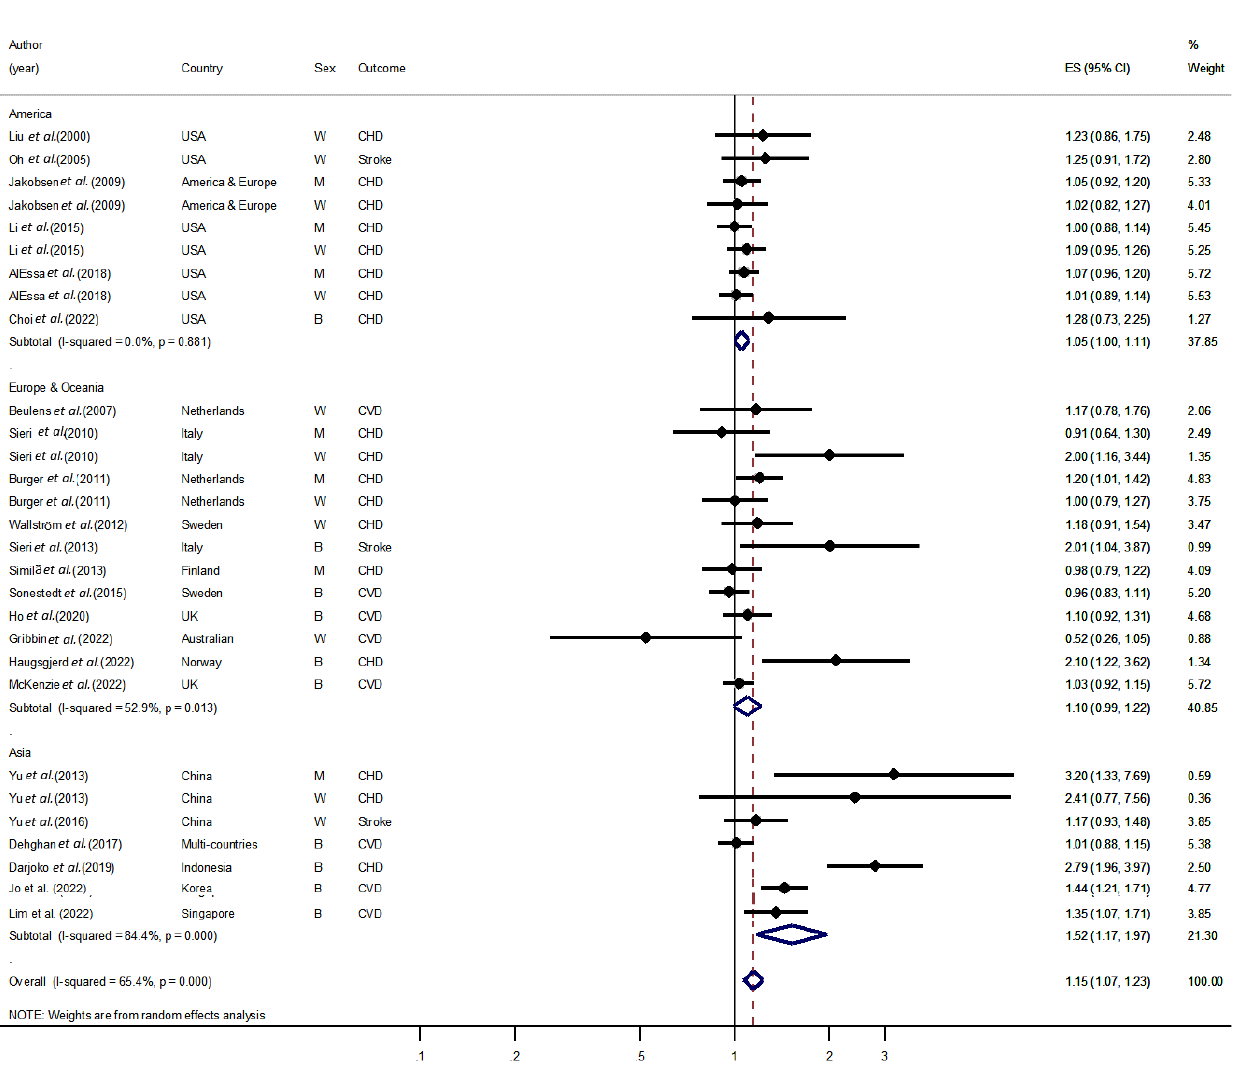
Figure 2. Forest plot of the association between carbohydrate intake and cardiovascular disease stratified by continent. ES, effect size; CVD, cardiovascular disease; CHD, coronary heart disease; W, women; M, men; USA, United States of America; UK, United Kingdom. [6,12–18,25–39]